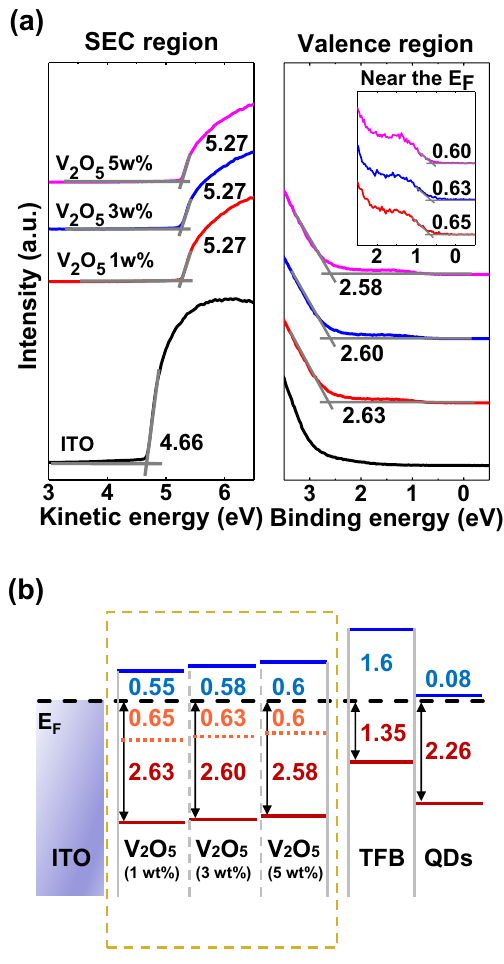
Figure 2. ( a ) UPS spectra of ITO and various concentration V 2 O 5 films on ITO at the secondary cutoff and E F regions. To clarify the gap state, inset shows near the E F . ( b ) Energy level diagram of the hole injection region of the QLEDs. Inside the dotted square, gap states and HOMO levels of different concentration V 2 O 5 films on ITO are